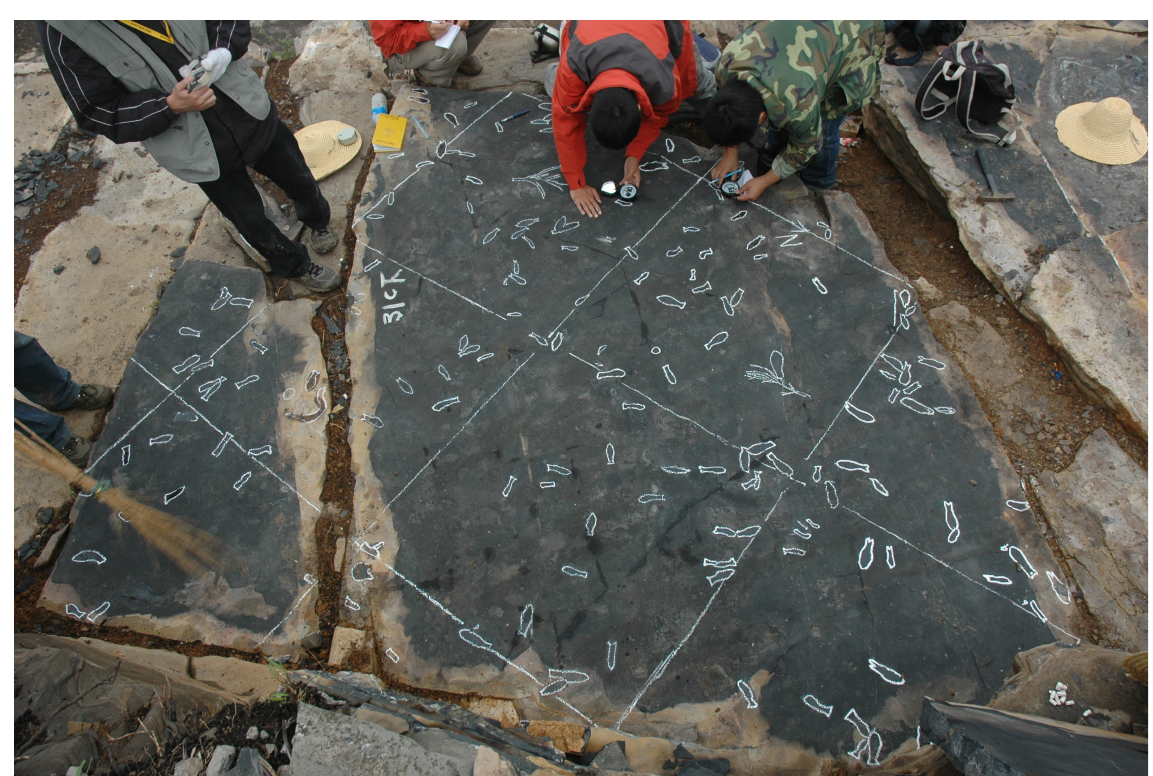
Figure 7. At some horizons at Luoping fishes occur in dense accumulations. Here, researchers are mapping and measuring the density of occurrence of the fossils. Photograph by Q.Y.Z.